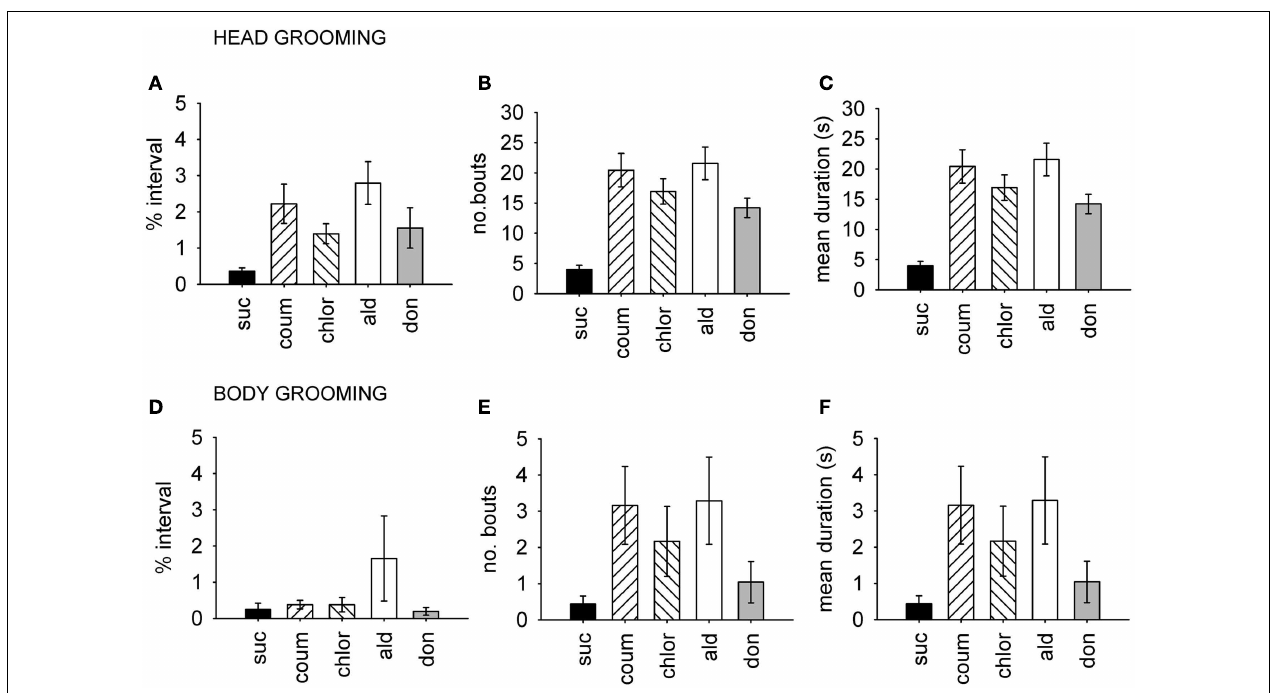
of grooming. (B,E) Show count data, expressed as the mean number of times ( ± SEM) bees performed the grooming behavior. (C,F) Show the mean duration ( ± SEM) in seconds of each grooming episode. N ≥ 23 for each treatment group. Suc, sucrose; Coum, coumaphos; Chlor, chlorpyrifos; Ald, aldicarb; Don, donepezil.